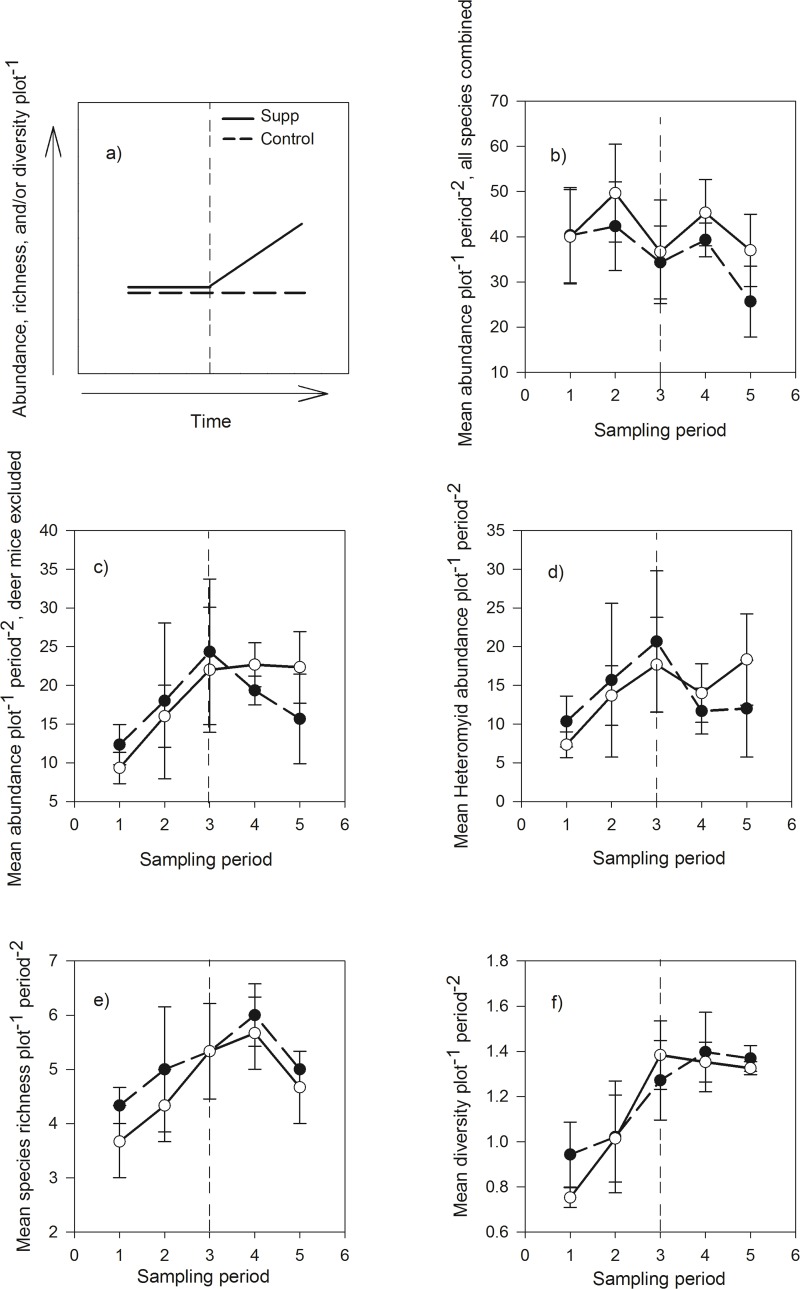
Effects of Cheatgrass Supplementation on Small Mammal Communities.Graph a) depicts the predicted effect of cheatgrass supplementation on the abundance, species richness, and/or diversity of native consumers over time. If additional resources subsidize native consumers, supplementation should cause changes in consumer demography over time (line slope) to diverge between control (“Control”) and cheatgrass-supplemented (“Supp”) communities. Graphs b-f) depict the observed effect of cheatgrass supplementation over time (“Sampling period”) on mean ± SE b) abundance of all small mammals combined, c) abundance of all small mammals combined excluding deer mice, d) abundance of Heteromyids, e) species richness, and f) Shannon-Wiener diversity on control (non-supplemented; filled circles) and experimental (cheatgrass-supplemented; open circles) plots in a Great Basin ecosystem (n = 3). Vertical dashed lines represent the time at which cheatgrass supplementation was initiated. All P > 0.55.